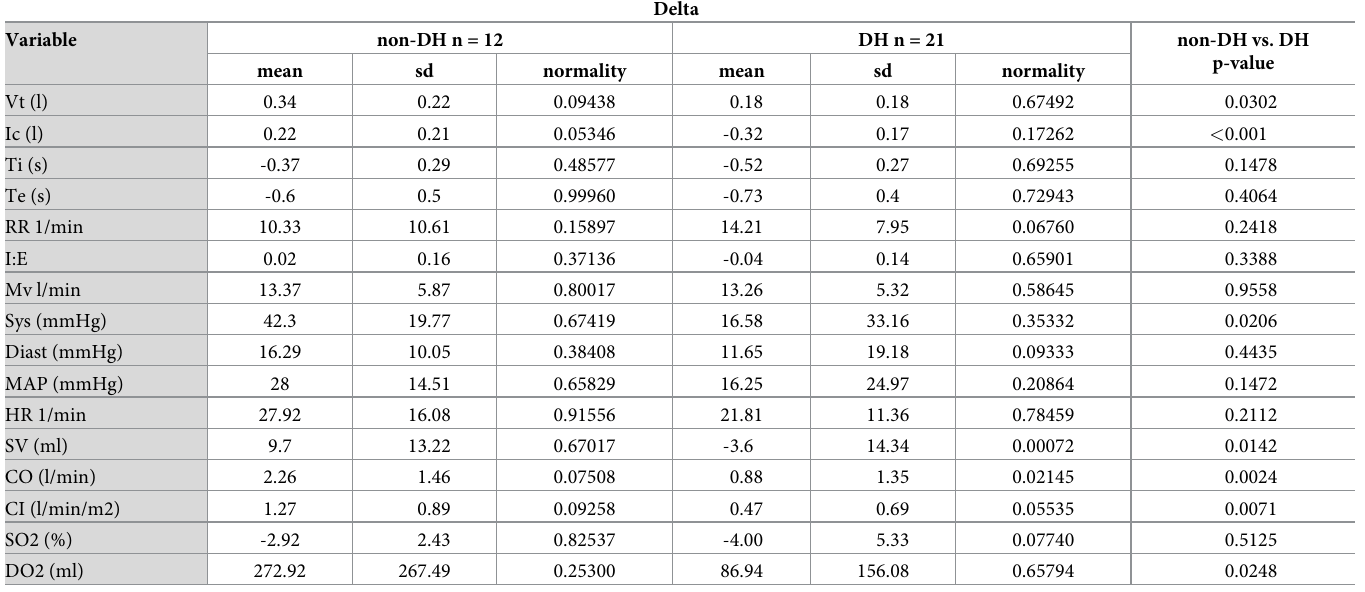
Table 3. Differences regarding respiratory volumes, breathing patterns, cardiovascular parameters, oxygen saturation, oxygen delivery and left ventricular ejection time index by DH and non-DH